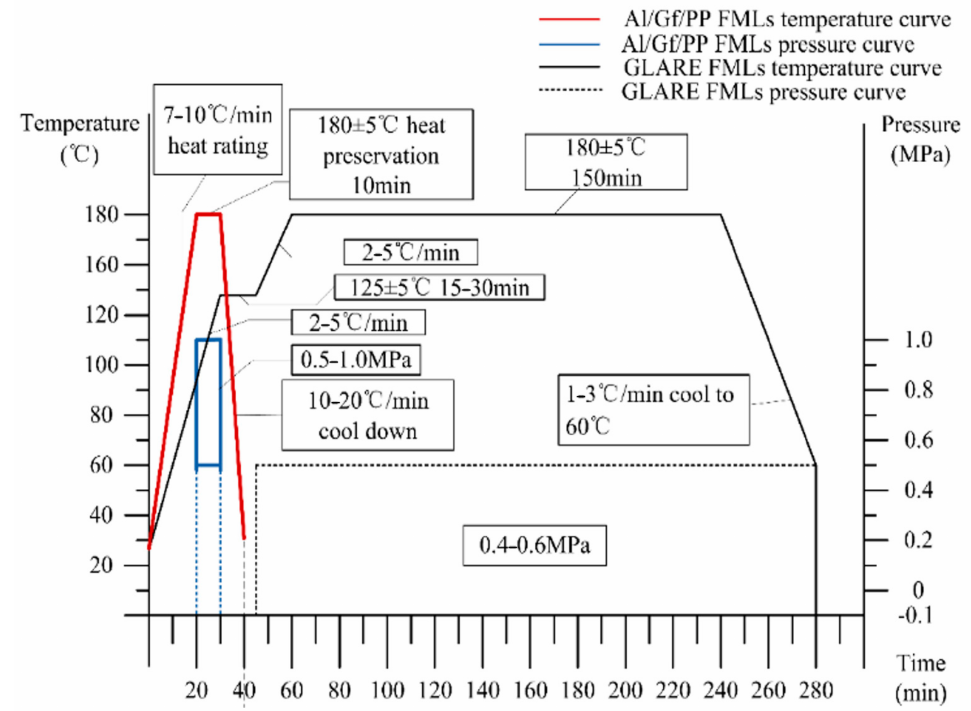
Figure 2. Curing curve of Al/Gf/PP